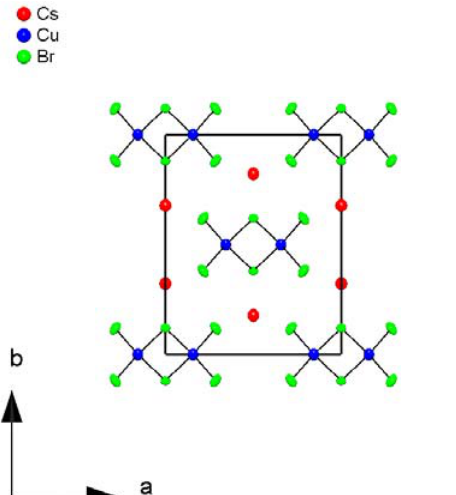
Br (left) and (HPip)Cu 2 3